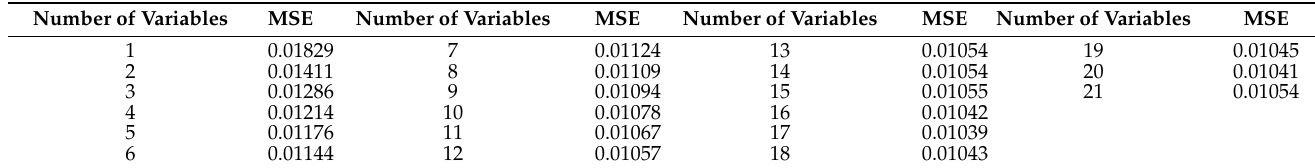
Table 2. Number of influence factor variables and root mean squared error (MSE).